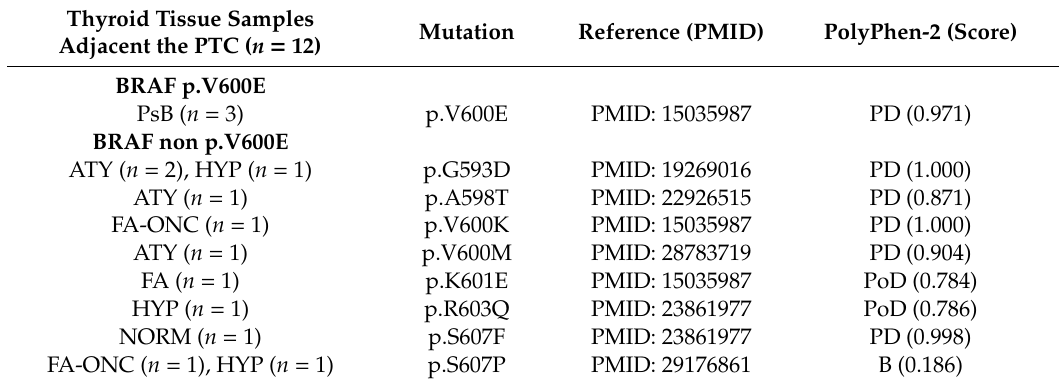
Table 3. Type of BRAF exon 15 mutations found in thyroid tissue adjacent to PTC and their pathogenicity prediction score